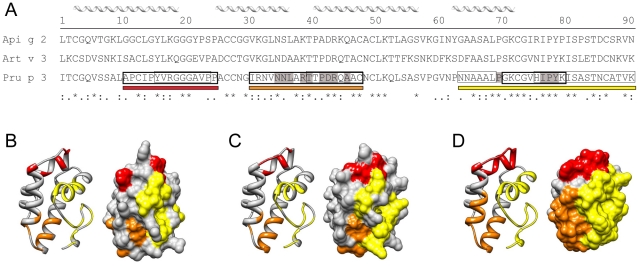
Sequence alignment and homology modeling of LTP.Primary sequence alignment of the mature protein sequences of celery stalk, mugwort pollen and peach LTP (A). Previously identified IgE-binding epitopes of Pru p 3 are labeled with boxes; thick and thin boxed amino acids correspond to peptides identified by Garcia-Casado et al [26] and Borges et al [25], while highlighted amino acids in grey were identified by mimotope mapping [27]. Homology modeling of Api g 2 (B), Art v 3 (C) and Pru p 3 (D) based on the structure of Pru p 3 (pdb: 2B5S). Identified IgE epitopes of Pru p 3 are depicted as red, orange, and yellow bars in the sequence and structure of the molecule. Conserved residues of the Pru p 3 epitopes are depicted colored in the models of Api g 2 and Art v 3.